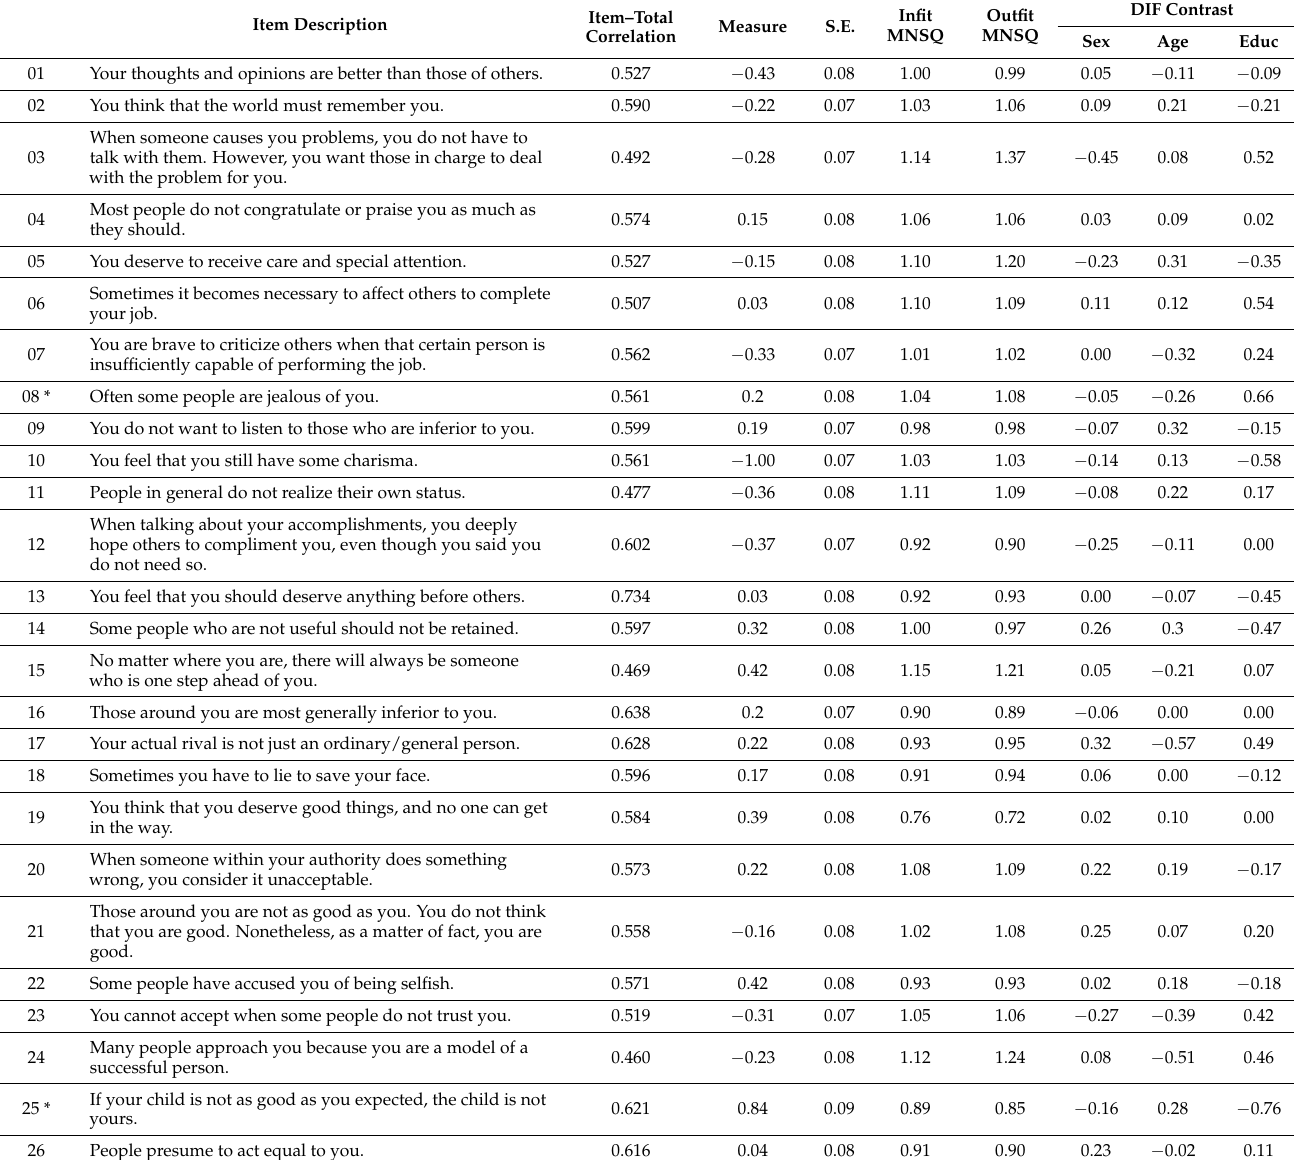
Table 3. Rasch fit statistics for the Narcissistic Personality